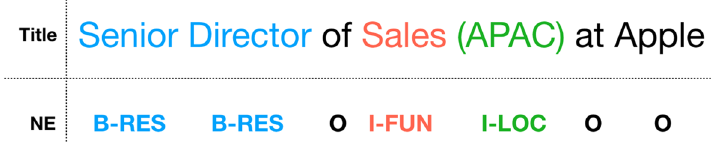
Fig. 1 An example of the occupational NER task, with tokens indicating RES ponsibility, FUN ction, and LOC ation. The NE tags are also added with positional prefixes using BIOES scheme, i.e., B egin, I nside, O thers, E nding and S